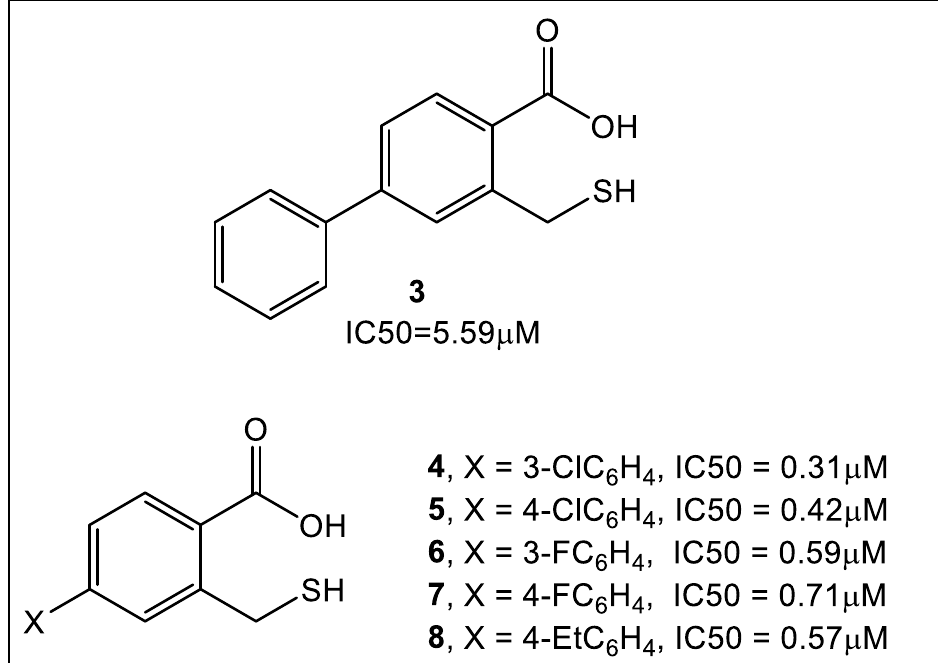
Figure 3. Fragments guiding lead derivatization of NDM-1 inhibitors derived from the natural